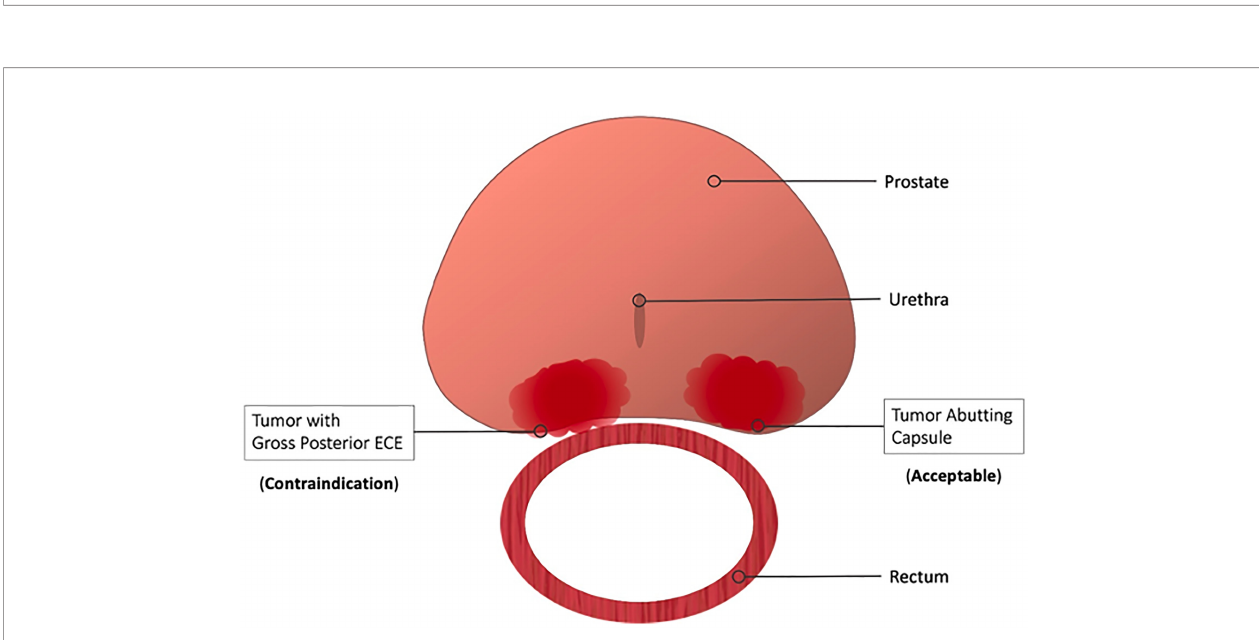
FIGURE 4 | Representative SBRT patient treated with focal dose escalation and hydrogel rectal spacer. The patient received 40 Gy in 5 fractions to the prostate with an integrated boost to 50 Gy while maintaining excellent OAR dosimetry.